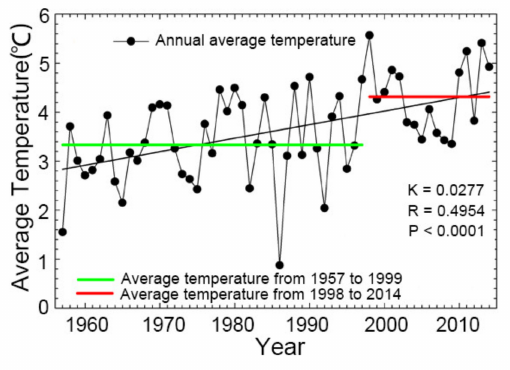
Figure 10. The annual average temperature of the Tashkurgan meteorological station from 1957 to